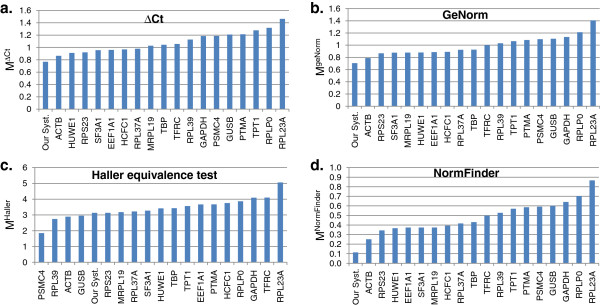
Evaluation of candidate reference gene expression stability by RT-qPCR. Gene expression variations calculated for aggregated set of samples by a: comparative ΔCt (MΔCt); b: geNorm (MgeNorm) and d: NormFinder (MNormFinder). c: Maximum fold changes of gene expression levels MHaller calculated by Haller equivalence test.